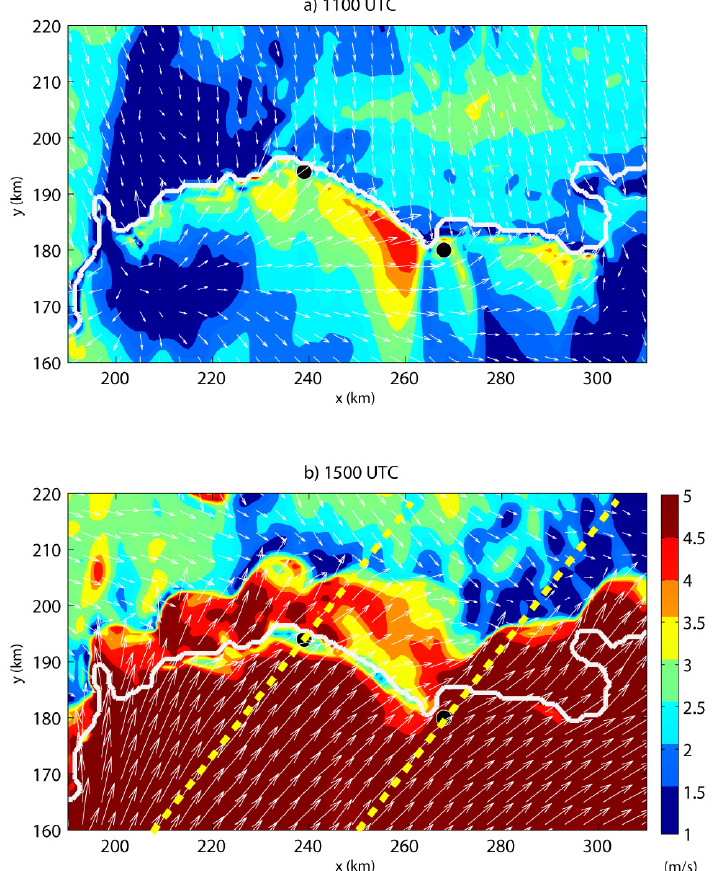
Fig. 4. Wind speed (filled contours) and wind vectors at 10ma.g.l. in the control simulation valid at (a) 11:00UTC and (b) 15:00UTC. The black circles depict the location of the Portland Harbour and Lyme Bay observational platforms (Fig. 1a), and the yellow dashed lines correspond to the sections in Figs. 7 and